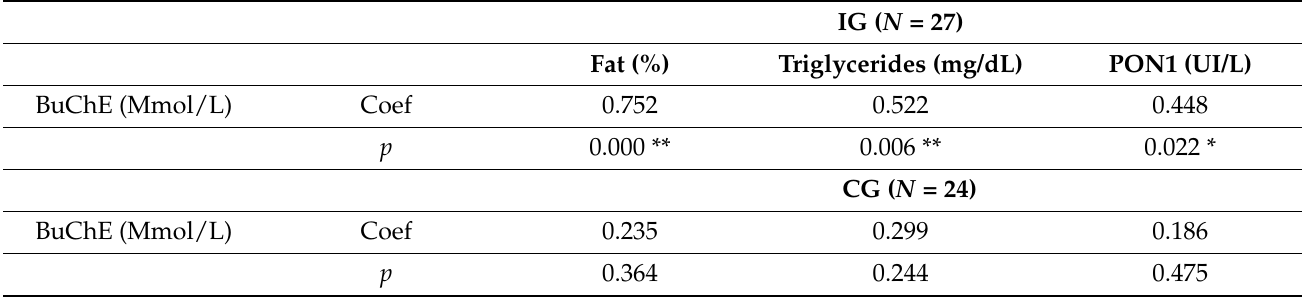
Table 3. Correlation in the study between BuChE and the other variables after intervention (post-test), both in the intervention and the control